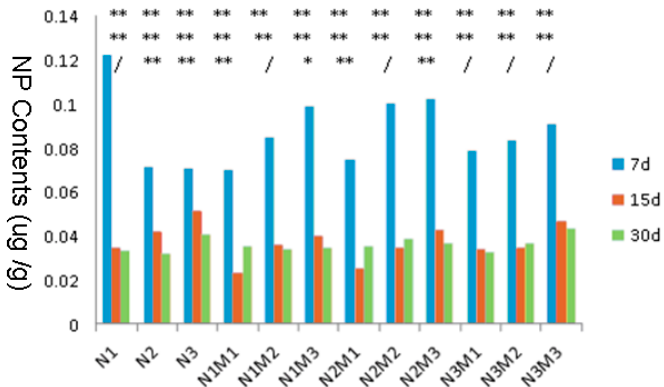
Figure 1. Statistical analysis of the content variation of 4-nonylphenol (4-NP) in liver at Day 7, Day 15 and Day 30. N, 4-NP; M, montmorillonite. Table 3. Statistical analysis of 4-NP contents in liver at Day 7.